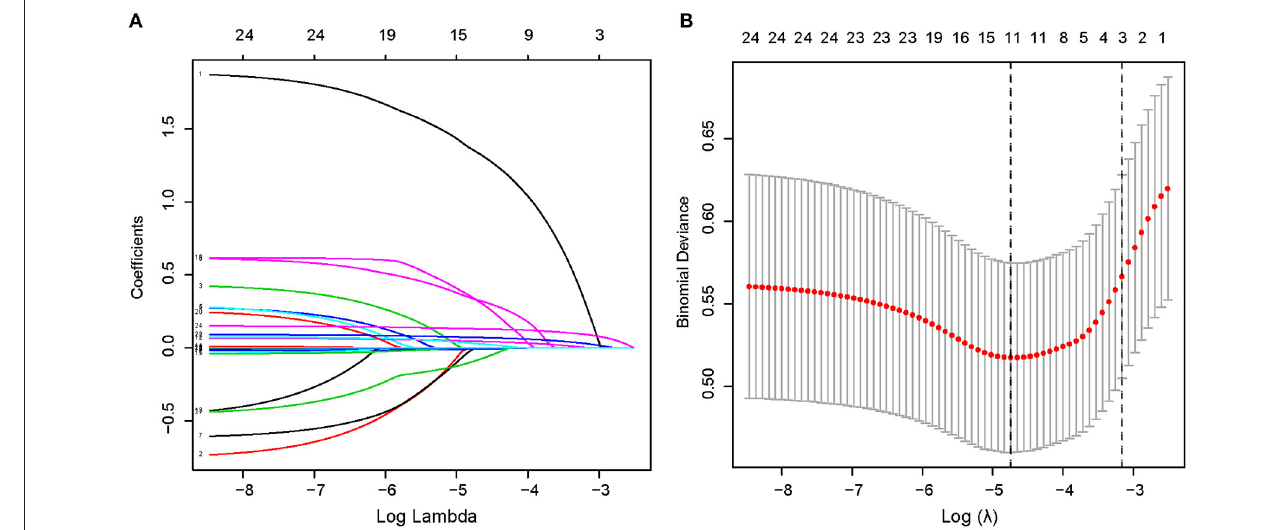
FIGURE 2 | Demographic and clinical feature selection using the LASSO binary logistic regression model in a total of 553 patients. (A) The selection of the best parameter (lambda) in the LASSO model uses five-fold cross-validation with the lowest standard. The relationship curve between partial likelihood deviation (binomial deviation) and log(lambda) was plotted. Dotted vertical lines were drawn at the optimal values by using the minimum criteria and the 1 SE of the minimum criteria (the 1—SE criteria). (B) LASSO coefficient profiles of the 11 features. A coefficient profile plot was produced against the log(lambda) sequence. A vertical line was drawn at the value selected using five-fold cross-validation, where optimal lambda resulted in five features with non-zero coefficients. LASSO, least absolute shrinkage and selection operator; SE, standard error.